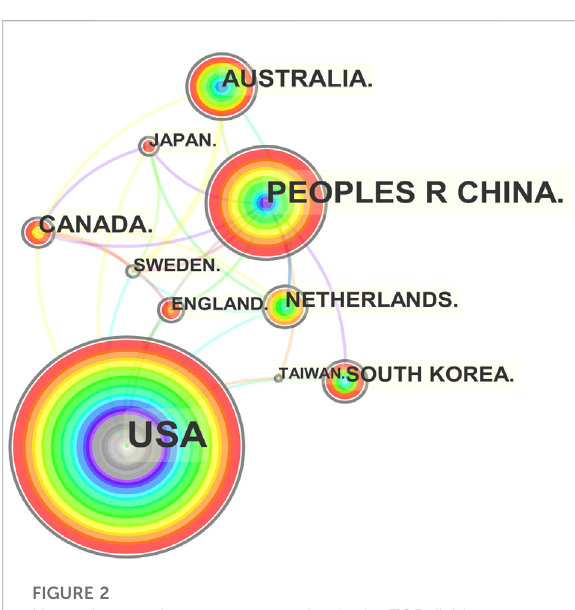
FIGURE 2 Network map of country cooperation in the TOD fi